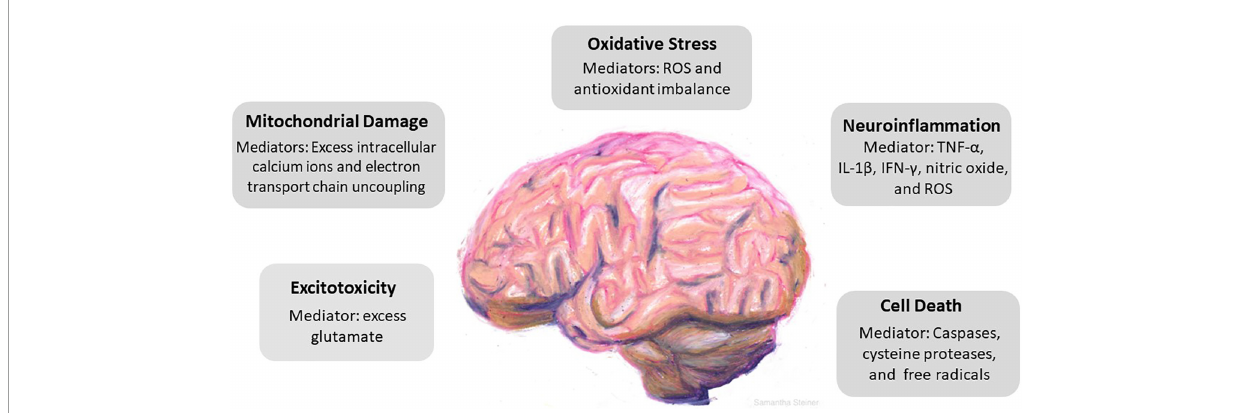
FIGURE1 Cascade of cellular events driven by traumatic brain injury (TBI). TBI incites a series of responses that include excitotoxicity, mitochondrial damage, oxidative stress, neuroinflammation, and cell death. Key mediators in each pathological event is identified. Excess glutamate causes overactivation of N-Methyl-d-aspartate receptors (NMDAr) and α -amino-3-hydroxy-5-methyl-4-isoxazolepropionic acid receptors (AMPAr) which induces neuronal overexcitation and swelling. Mitochondrial damage follows as a result of excess influx of intracellular calcium and uncoupling of the electron transport chain. The precipitous rise of reactive oxygen species and the brain parenchyma’s relatively low antioxidant capacity promotes oxidative stress. Neuroinflammation induces secondary damage via the release of proinflammatory cytokines, chemokines, and inflammatory mediators and ultimately leads to cell